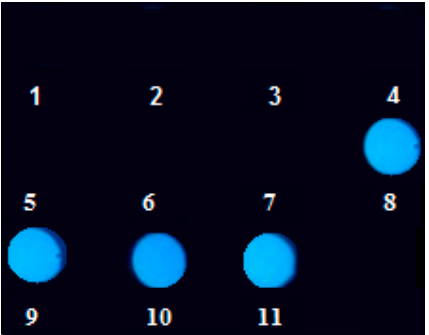
Figure 2. Photograph of oil drops of 11 samples applied to a black matte plate, placed in a dark place and illuminated with a UV LED lamp at λ = 365 nm. The sample type is presented in Table 1, please refer. Table 2. Summary of test results for all tested samples in relation to all developed test